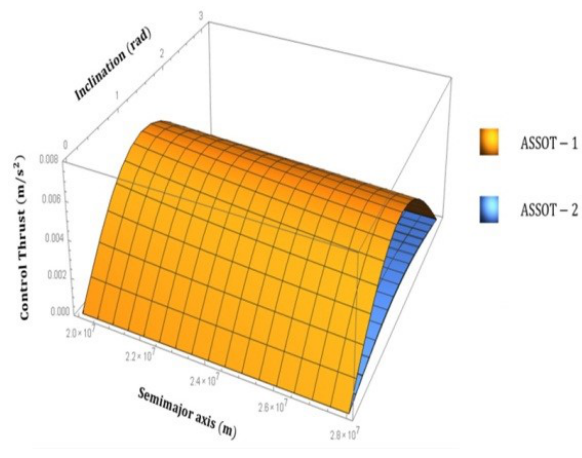
Figure 8. Control thrust vs. semimajor axis and inclination for all